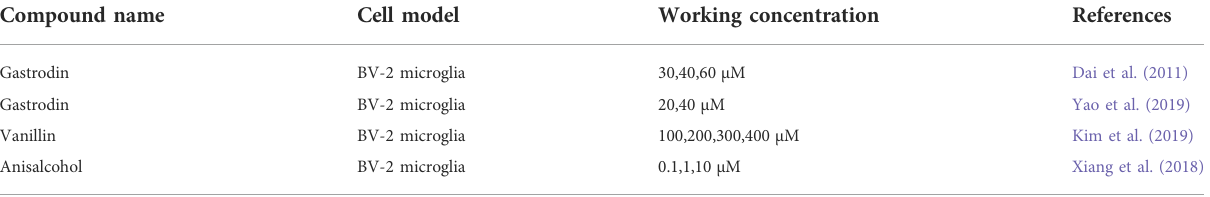
TABLE 3 The working concentration of anti-in fl ammation of Tianma